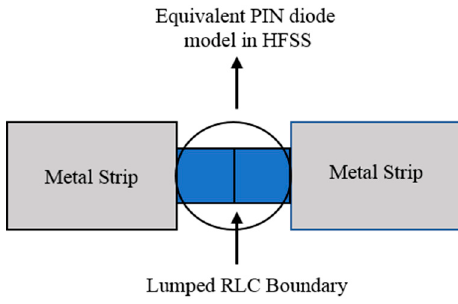
Figure 6. Modeling of the PIN diode in Ansoft HFSS (High Frequency Structure Simulator).